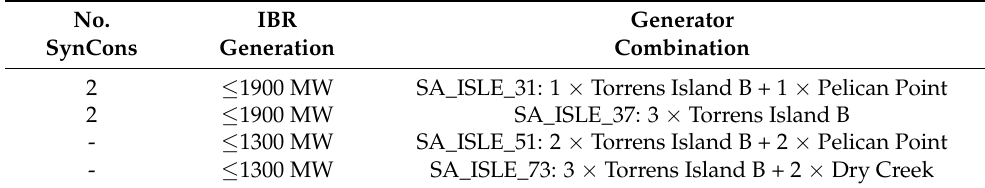
Table 8. South Australia minimum generator combinations under islanding operation